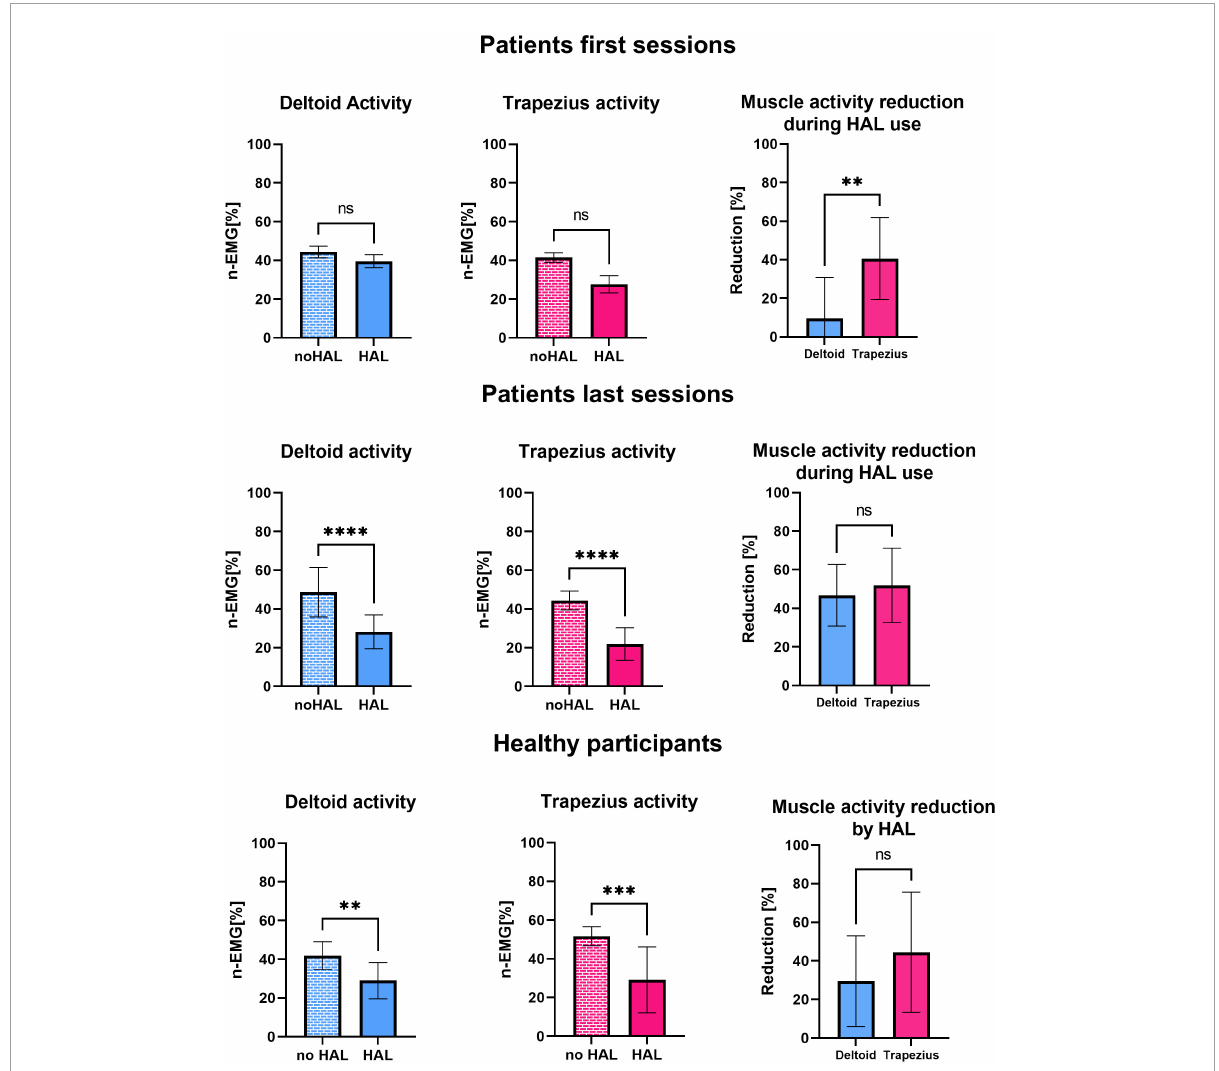
FIGURE6 Normalized activity of the deltoid with and without HAL, normalized activity of the trapezius with and without HAL, comparison of deltoid and trapezius activity reduction during HAL use averaged for the first 3 sessions of patients, the last 3 sessions of patients and healthy